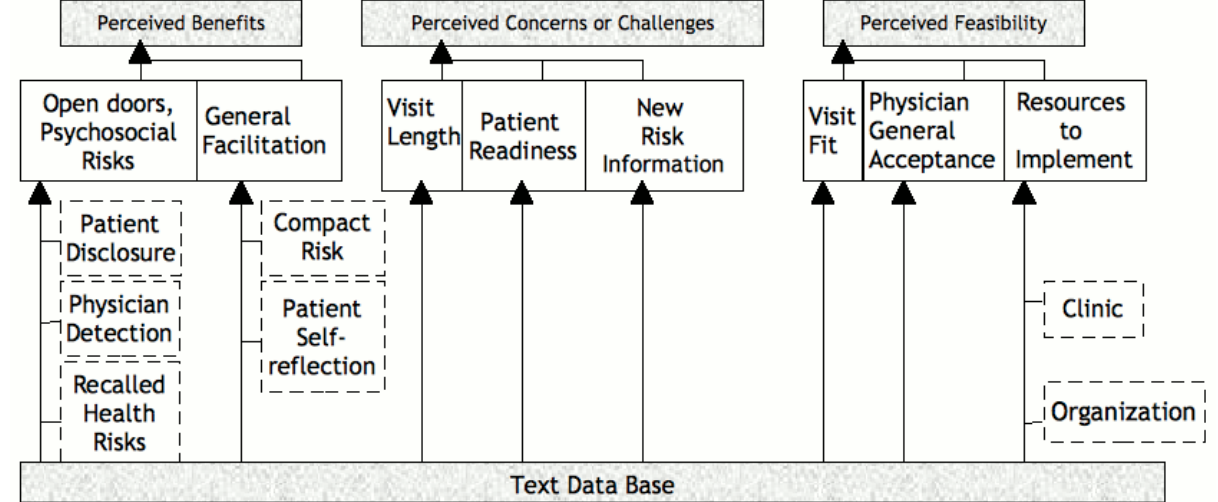
Figure 1. Physician in-depth interviews: themes, subthemes, and